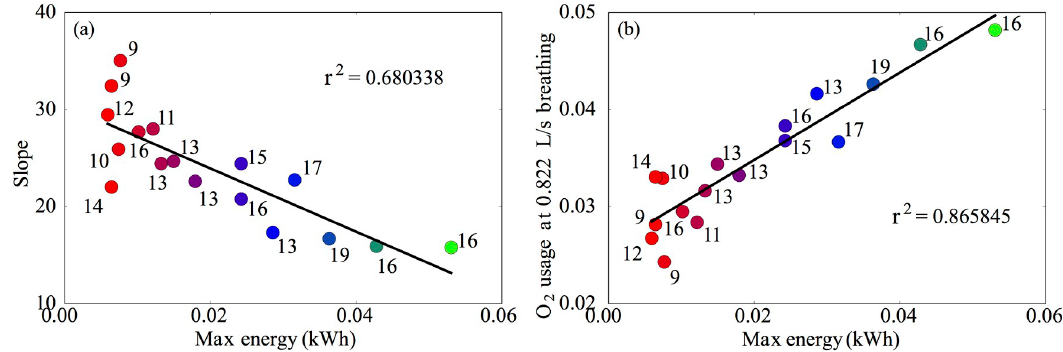
Fig 6. Slope of the fitted curves ( log _ V against _ VO ) from Fig 4(b) plotted against the total energy transfer during the test. We 2 E find a relatively poor characterisation of the variance between performances. (b) By instead plotting the oxygen consumption at a fixed rate of breathing, we better capture differences in performance.